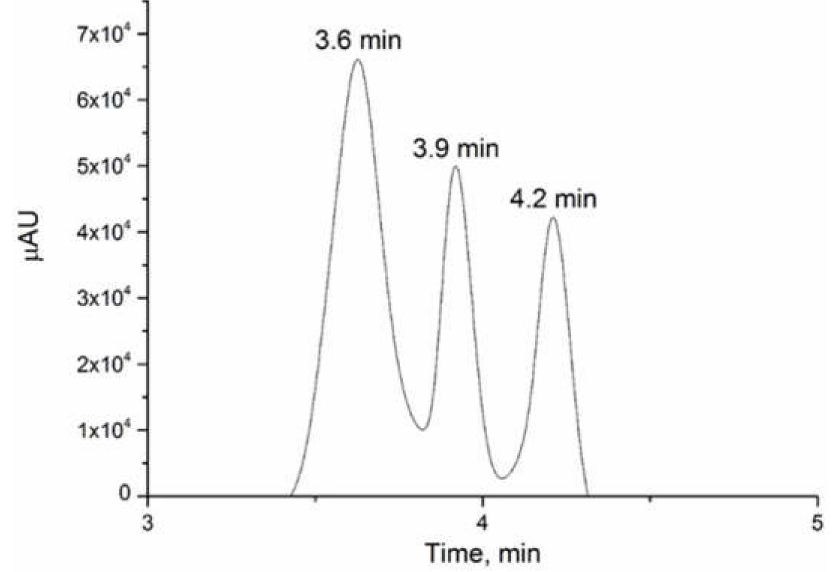
Figure 5. Chromatogram of a chili extract by UV–VIS detector at 280 nm obtained with the optimized gradient conditions (Table 1).